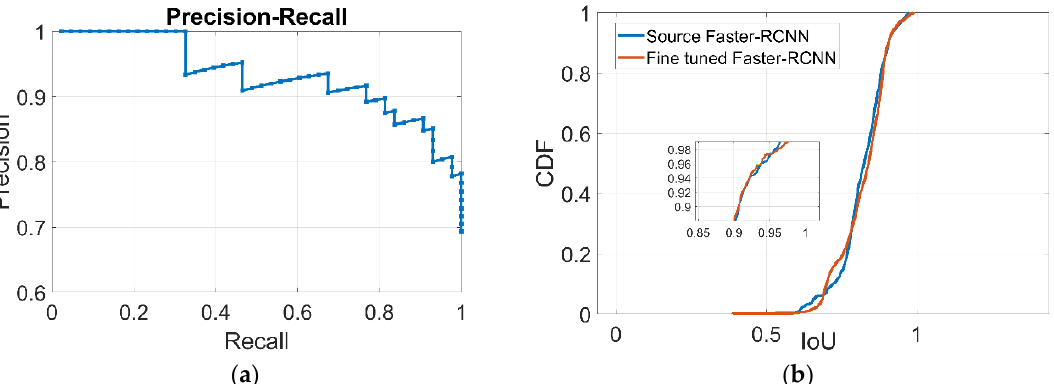
Figure 5. The performance of the fine-tuned Faster R-CNN. ( a ) The Precision-Recall Curve; ( b ) The cumulative probability distribution (CDF) of IoU.